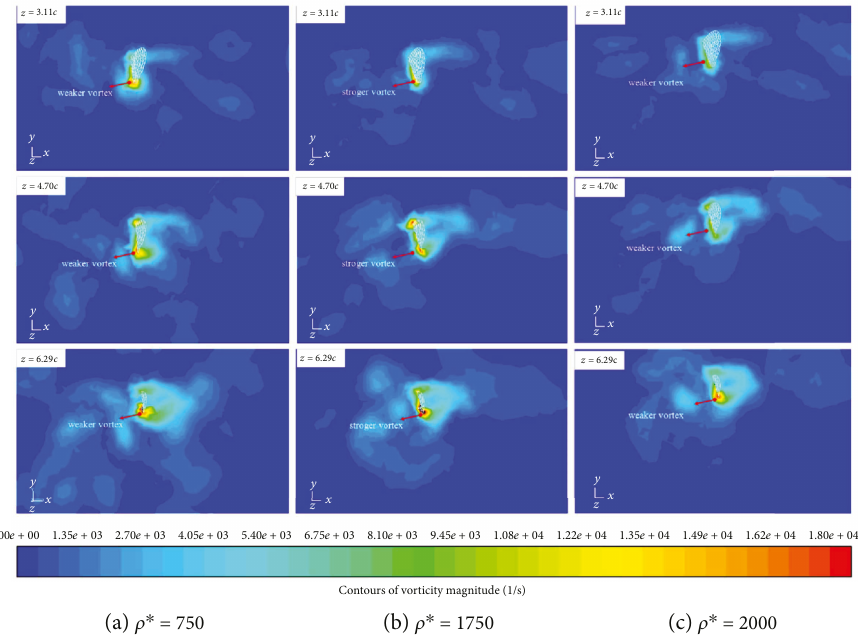
Figure 16: The vortex of the fl exible wing with ρ ∗ = 750 , 1750, and 2000 at t =0.70 T , z =3.11 c , 4.70 c , and 6.29 c